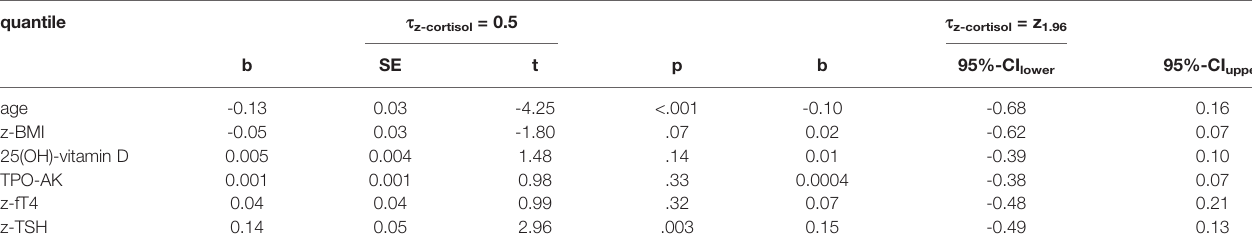
TABLE 4 | Results - quantile regression.